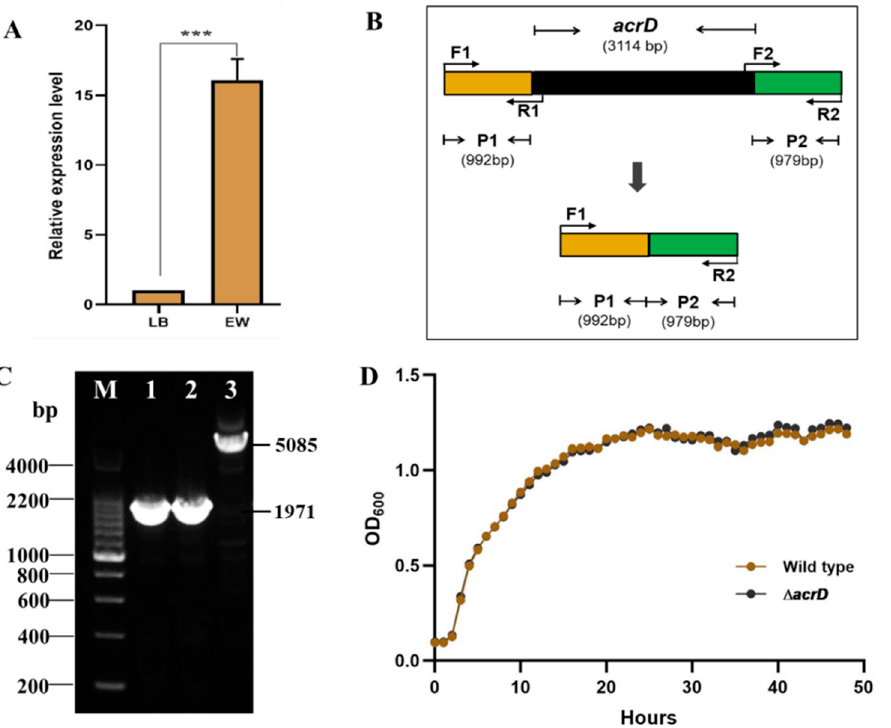
Figure 1. ( A ) Relative expression level of acrD of S. Enteritidis in whole egg white (EW) compared to that of Luria-Bertani (LB) broth at the mRNA level. Vertical bars show standard deviation. Asterisk indicates statistical differences according to Duncan’s multiple range test at p < 0.001 (***) level. ( B ) The in-frame deletion of acrD . P1: upstream fragment, P2: downstream fragment. ( C ) Confirmation of the successful construction of ∆ acrD mutant by PCR using F1 and R2 primers. M: DNA marker, 1/2: Δ acrD mutant, 3: wild type. ( D ) The growth curve of S. Enteritidis wild type and Δ acrD mutant in LB broth.